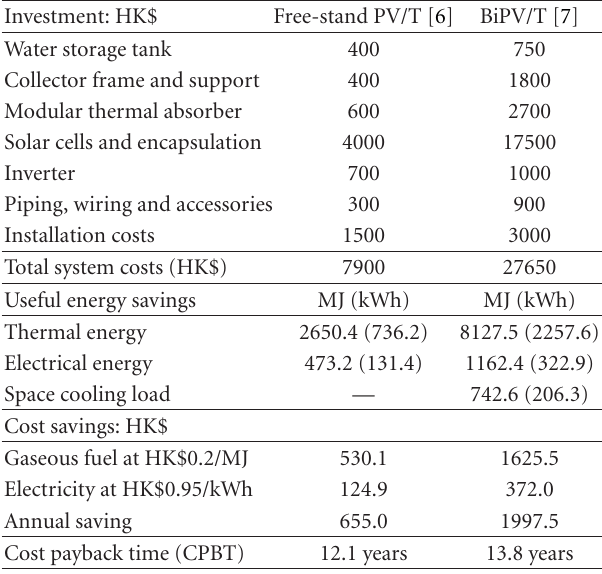
Table 6: Evaluation of cost payback